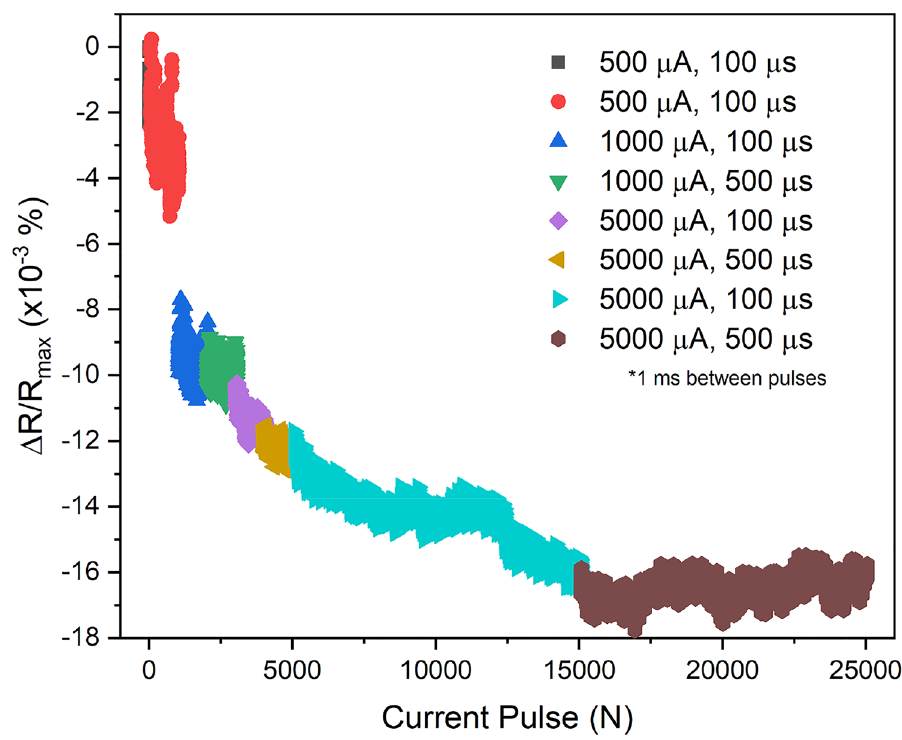
Figure 2. Current-induced crystallisation. Resistance change after a series of pulse current applications of 500 µA up to 5 mA for 100 µs up to 500 µs in a GMR device of CFAS/Ag/CFAS with the same diameter of 150 nm × 100 nm as that measured in Fig. 1. The GMR ratios were measured using the conventional four probe setup with flowing a sensing current of 50